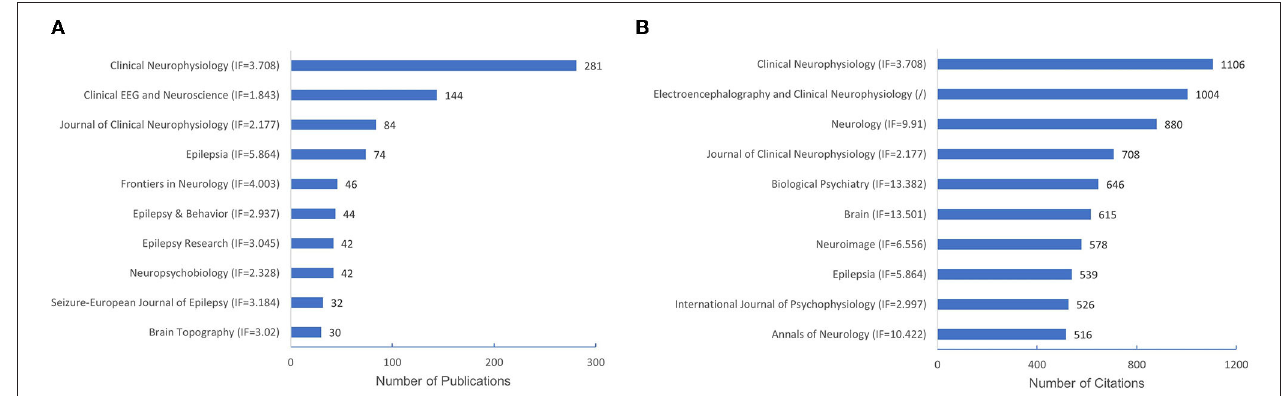
FIGURE 4 | The number of publications of the top 10 journals and co-cited journals. (A) The number of publications of the top 10 journals. (B) The number of citations of the top 10 co-cited journals.